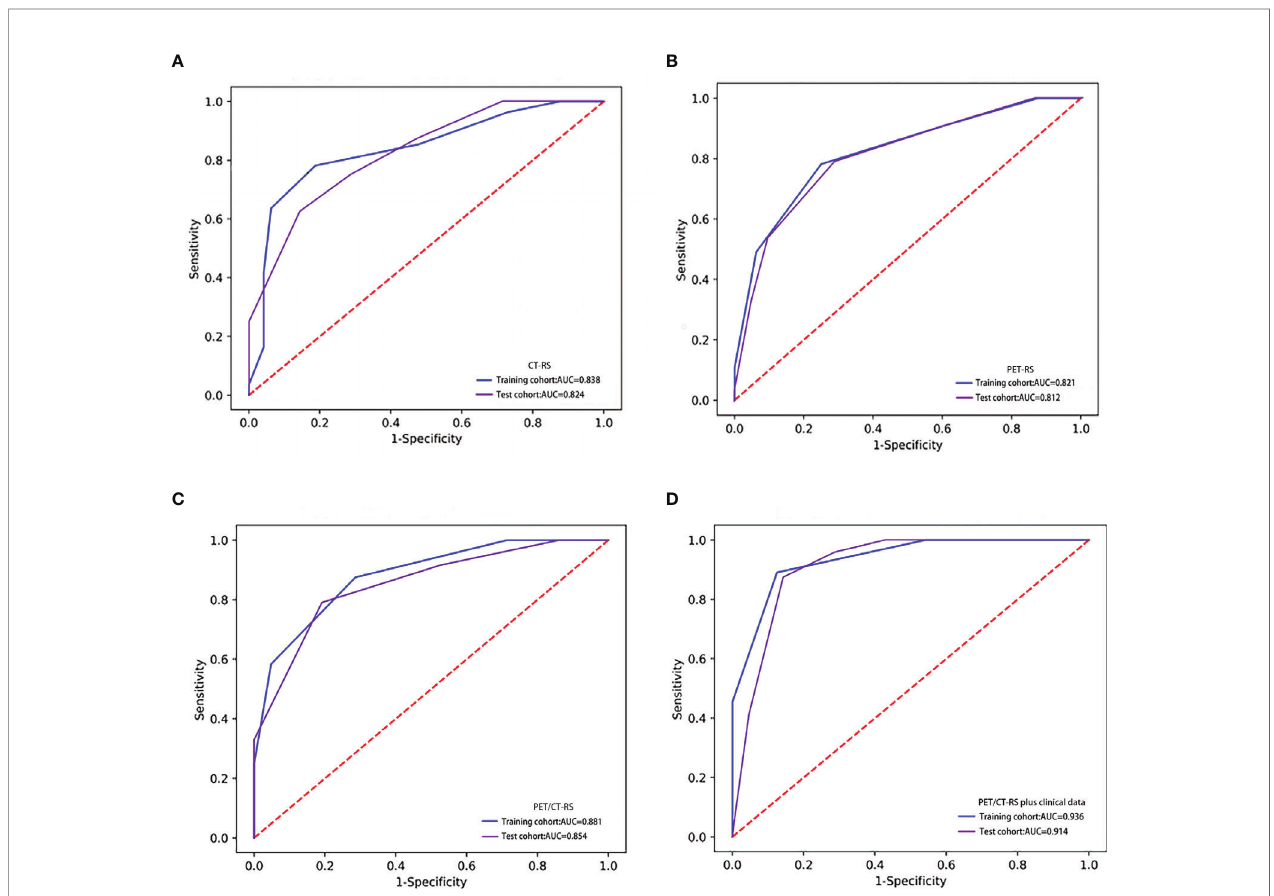
FIGURE 2 | ROCs of different radiomics models in the training and test set. (A) The ROC of CT-RS; (B) The ROC of PET-RS; (C) The ROC of PET/CT-RS; (D) The ROC of PET/CT-RS incorporating clinical and metabolic